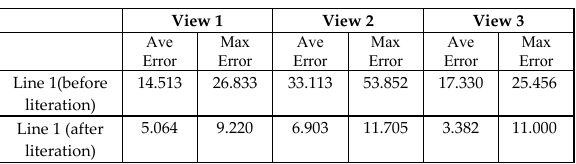
Table 2. Statistics of the clearance calculation errors (in